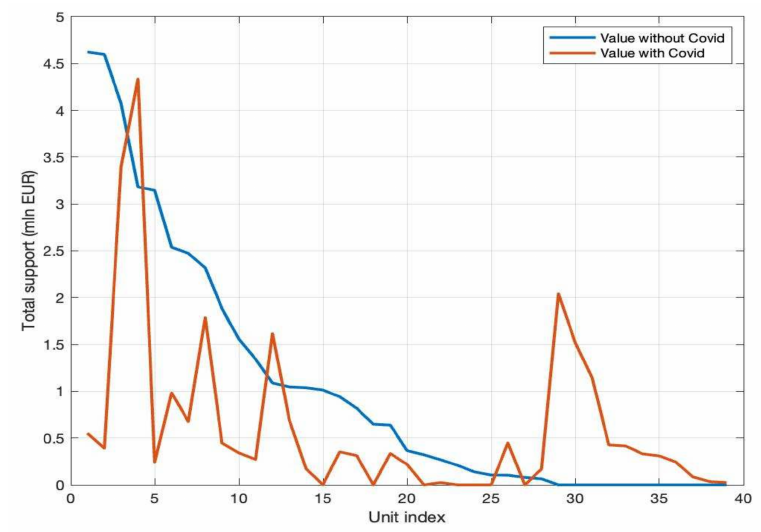
Figure 8. Characteristics of support (COVID division, without